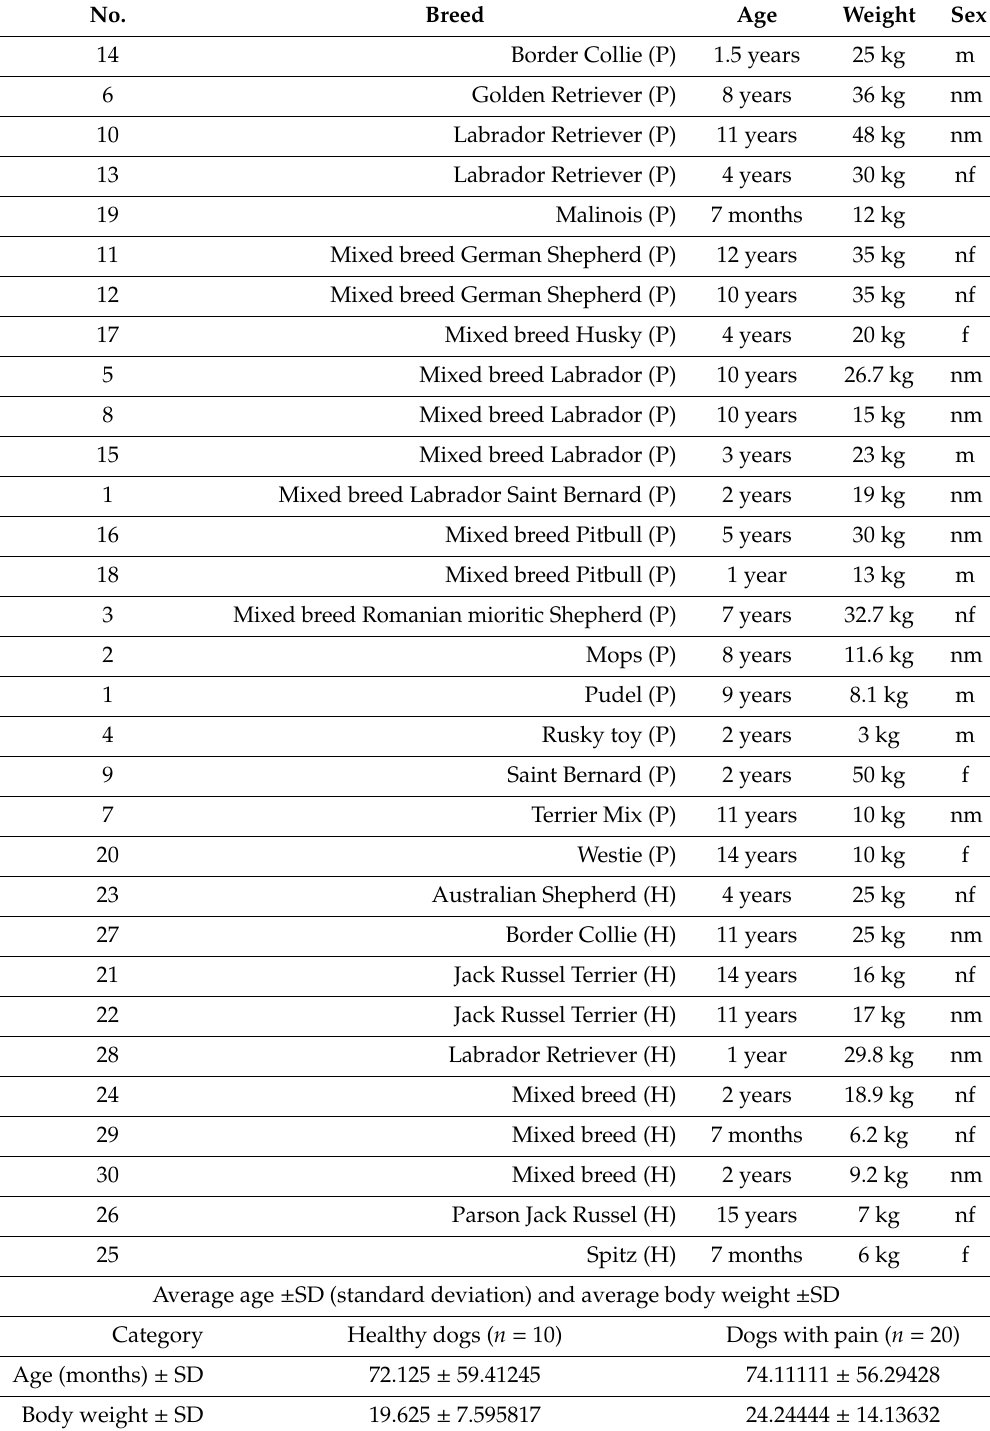
Table 1. Dogs of di ff erent categories included in the